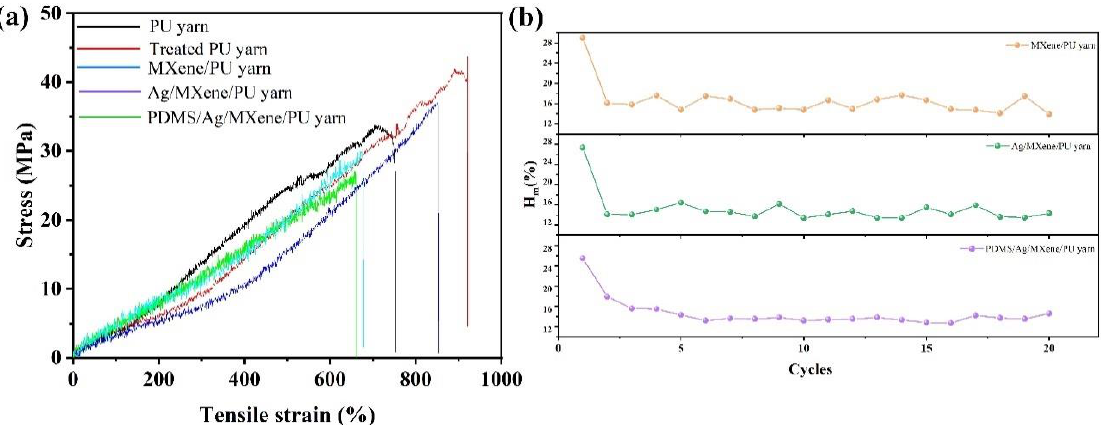
Figure 3. Mechanical performance, ( a ) strain–stress curves of different samples, ( b ) mechanical hysteresis of prepared conductive yarns.